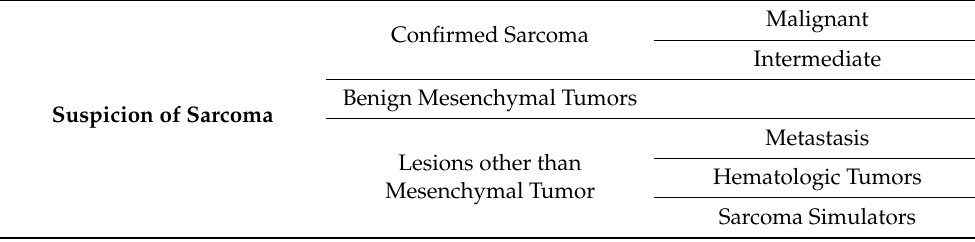
Table 1. Classification of mesenchymal biopsies.